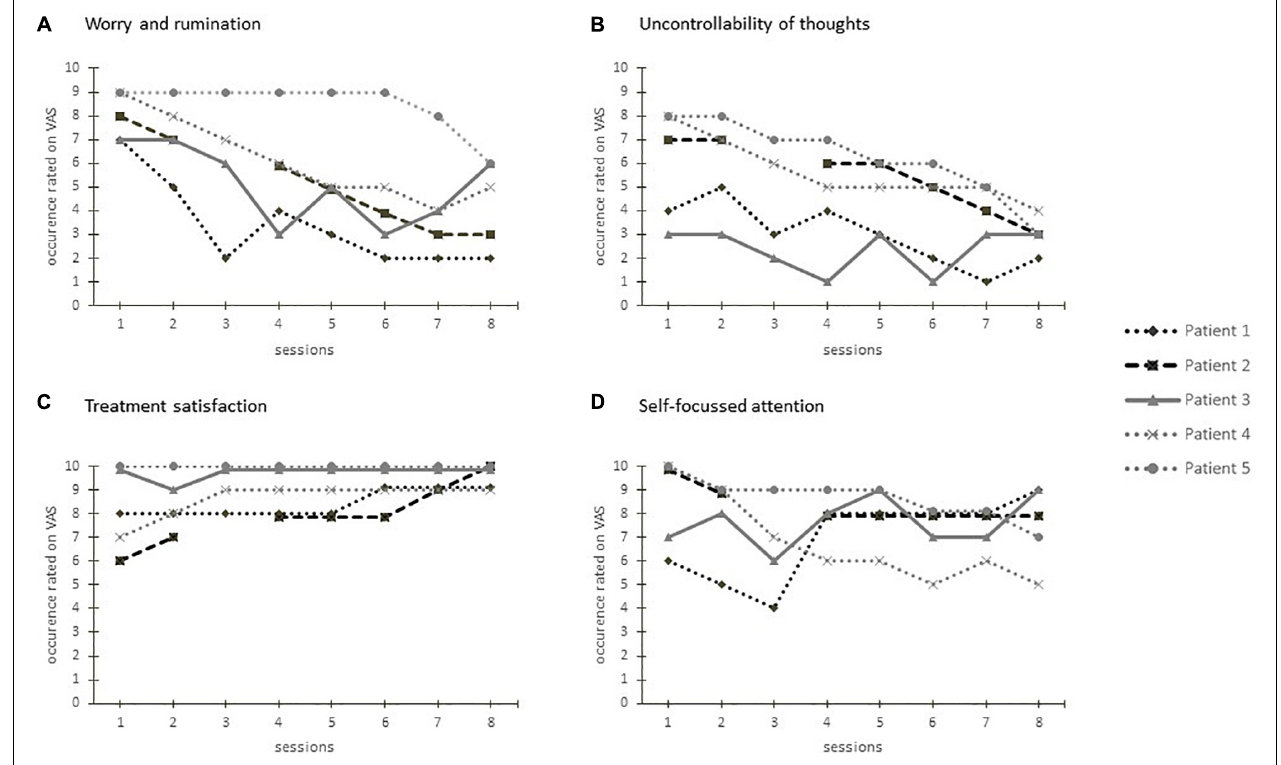
FIGURE 4 | Visual analog scales regarding worry and rumination (A) , perceived uncontrollability of thoughts (B) , treatment satisfaction (C) , and self-focused attention (D) after each treatment session for each